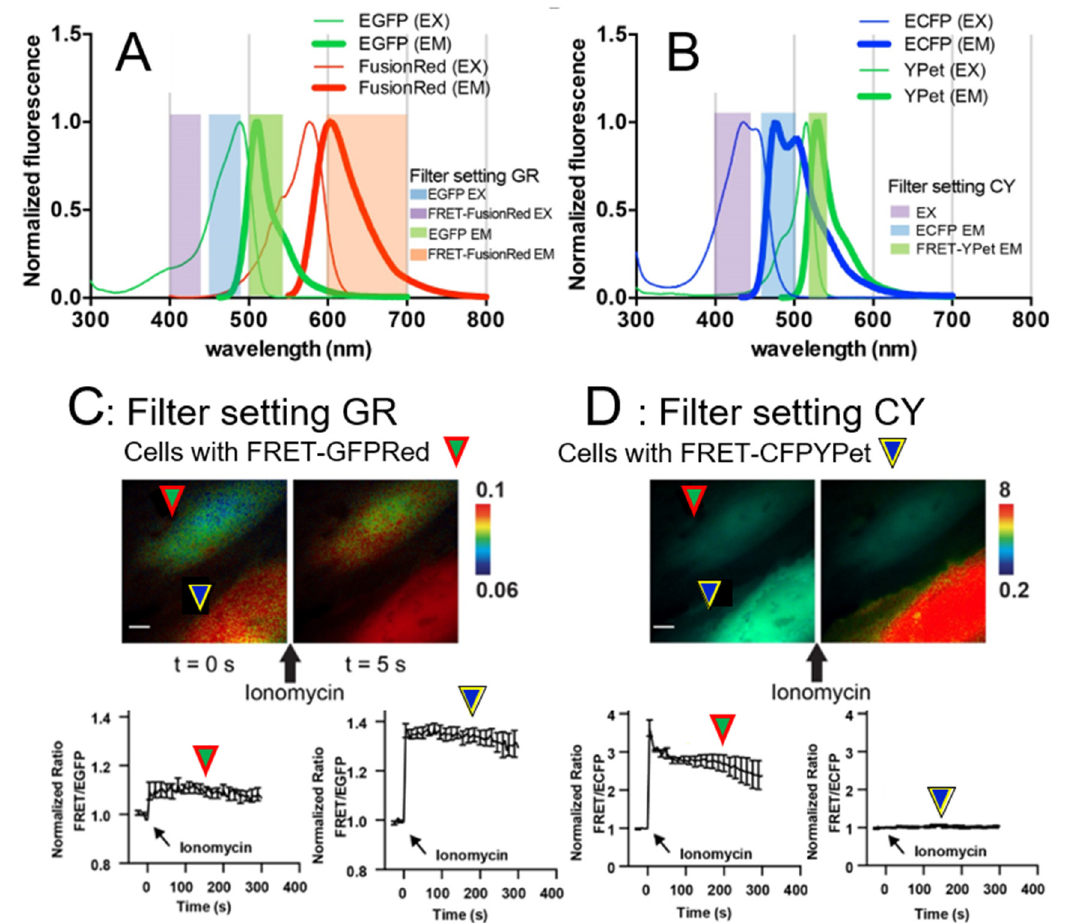
Figure 3. The characterization of a new FRET-based Ca 2 + biosensor with EGFP and FusionRed fluorophores (FRET-GFPRed) by chemical stimulation. A FRET-based Ca 2 + biosensor with ECFP and YPet (FRET-CFPYPet) was used for comparison. ( A ) Normalized fluorescence spectra showing excitation (EX, thin lines) and emission (EM, thick lines) of EGFP (green lines) and FRET-FusionRed (red lines) are presented. The filter setting GR has excitation filters for EGFP (blue region, 450–490 nm) and FRET-FusionRed (purple region, 400–440 nm) as well as emission filters for EGFP (green region, 500–550 nm) and FRET-FusionRed (red region, 600–700 nm). Time course of the typical FRET-GFPRed signal after ionomycin stimulation is presented in Figure 1B. ( B ) Normalized fluorescence spectra showing excitation (EX, thin lines) and emission (EM, thick lines) of ECFP (cyan lines) and YPet (green lines) are presented. The filter setting CY has an excitation filter (purple region, 400–450 nm) for ECFP / YPet and emission filters for ECFP (blue region, 460–500 nm) and YPet (green region, 520–550 nm). ( C , D ) Two Hela cells in one field of view are shown. The upper and lower cells were transfected with FRET-GFPRed and FRET-CFPYPet, respectively. The representative ( C ) FRET / EGFP and ( D ) FRET / ECFP ratio images of two cells before and after ionomycin stimulation are presented. ( C ) Time course of the FRET / EGFP signal ratio of FRET-GFPRed (left) and FRET-CFPYPet (right) indicating a spectral bleed-through of FRET-CFPYPet signal using the filter setting GR. ( D ) Time course of the FRET / ECFP signal ratio of FRET-CFPYPet (left) and FRET-GFPRed (right) indicating no spectral bleed-through of the FRET-GFPRed signal using the filter setting CY. ( C , D ) Normalized FRET / EGFP and FRET / ECFP signal ratios were obtained by live cell imaging using the filter settings GR and CY, respectively. Green arrowheads surrounded by red lines indicate HeLa cells transfected with FRET-GFPRed. Blue arrowheads surrounded by yellow lines represent cells transfected with FRET-CFPYPet. Black arrows represent ionomycin (chemical) stimulation. Scale bars represent 10 µ m. Error bars represent +/ − one